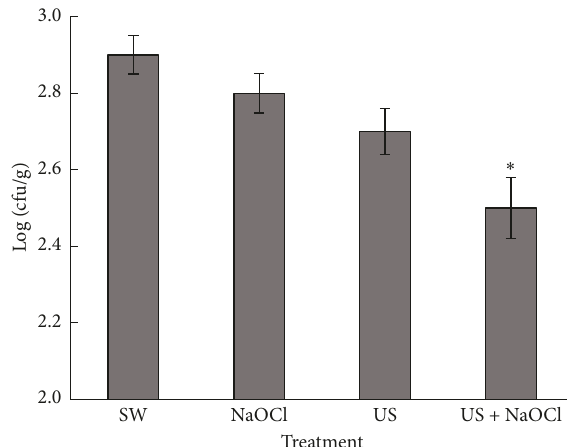
Figure 1: Mesophilic aerobic bacteria (MAB) count on sanitized and no sanitized melon. SW, sterilized water; US, ultrasound (40kHz, 500W); NaOCl, sodium hypochlorite (100mg/L). The difference is significant at p 0 . 05 by Tukey’s ∗ <